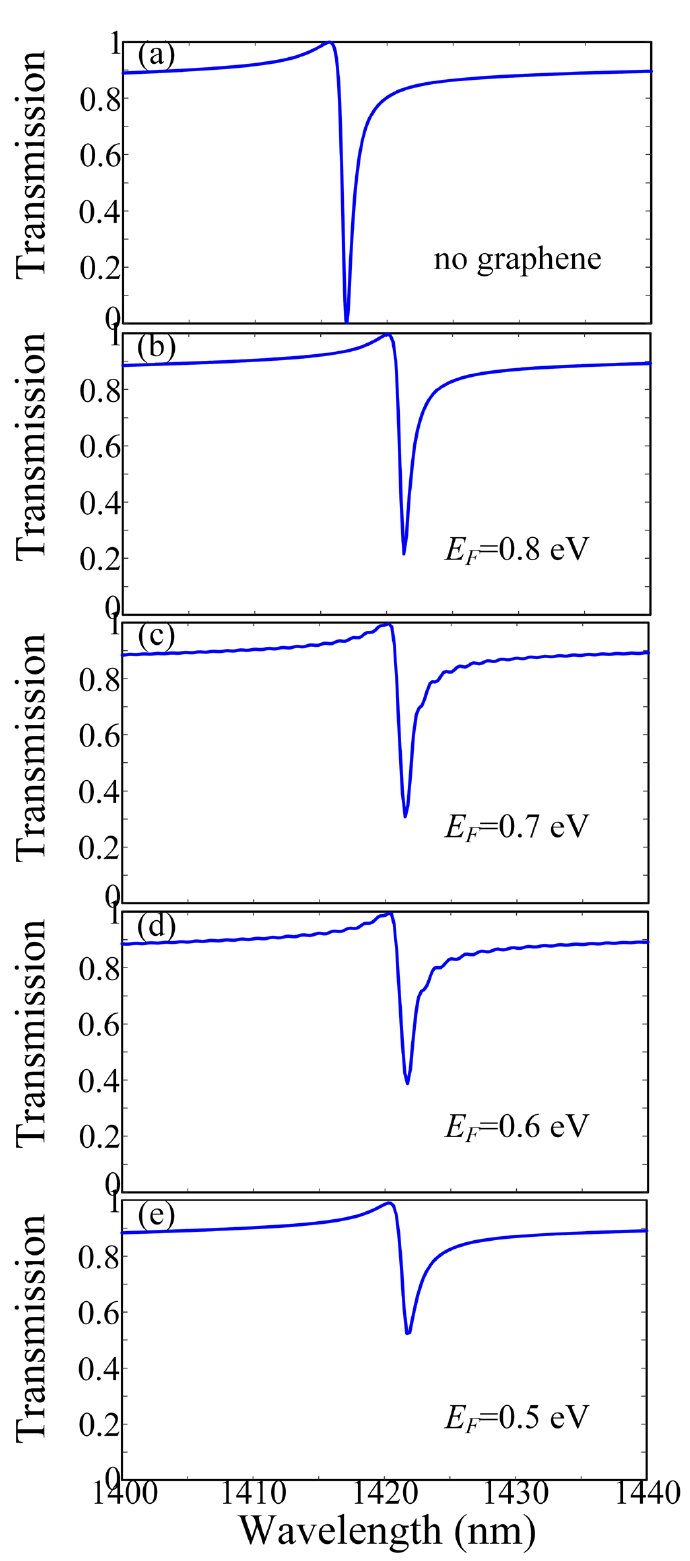
Figure 3. Transmission of the proposed optical modulator ( a ) without and with the different Fermi energies E F of graphene ( b – e ) when α = 75.